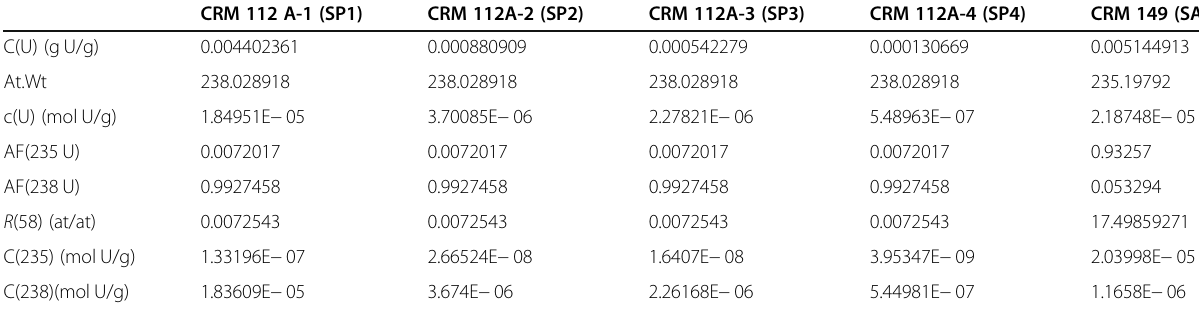
Table 1 Properties of the evaluated spike solutions from the CRM 112A (original stock) (CRM 112A-1, SP 1; CRM 112A-2, SP 2; CRM 112A-3, SP 3; CRM 112A-4, SP